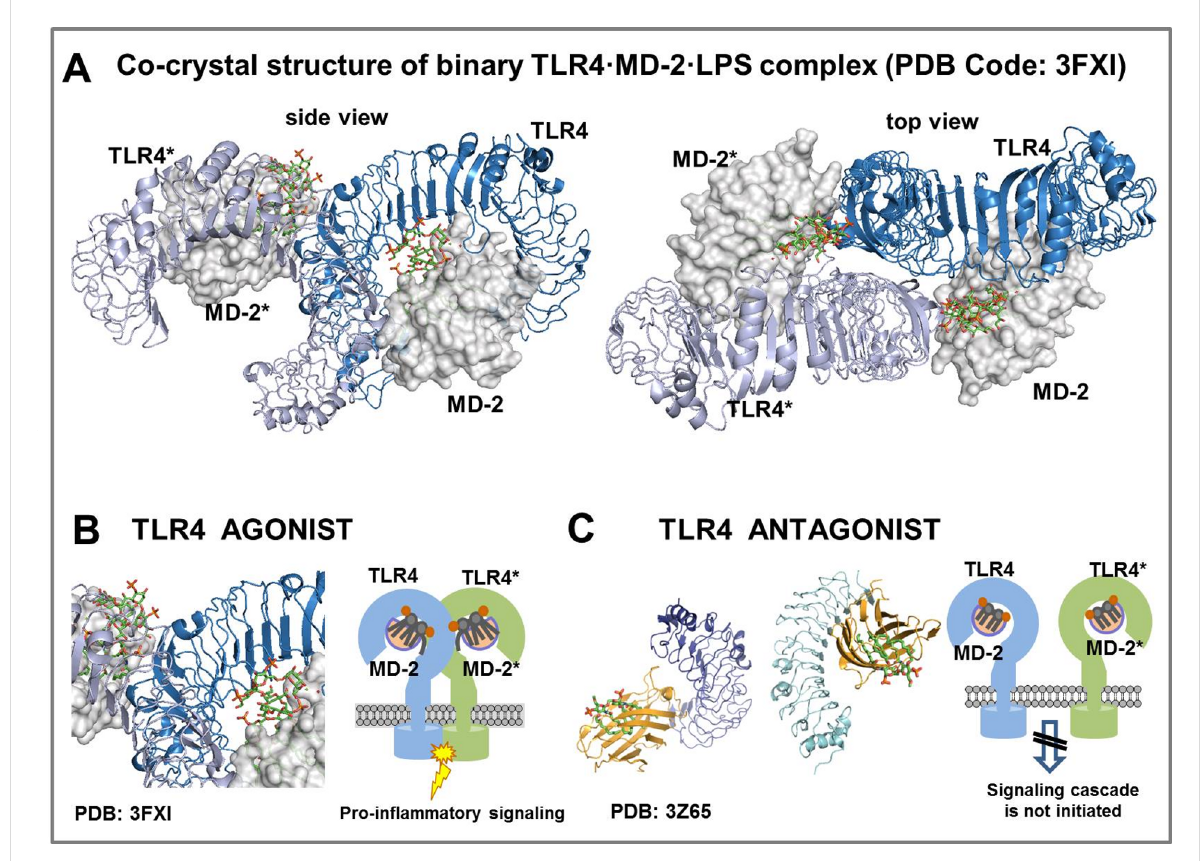
Figure 3: (A) Co-crystal structure of the homodimeric E. coli Ra-LPS·hMD-2 ∙ TLR4 complex (PDB code: 3FXI); (B) schematic representation of the E. coli lipid A induced activation of the MD-2 ∙ TLR4 complex (C) schematic representation of the interaction of TLR4 antagonist eritoran with MD-2 ∙ TLR4 complex. Images were generated with PyMol, ChemDraw and